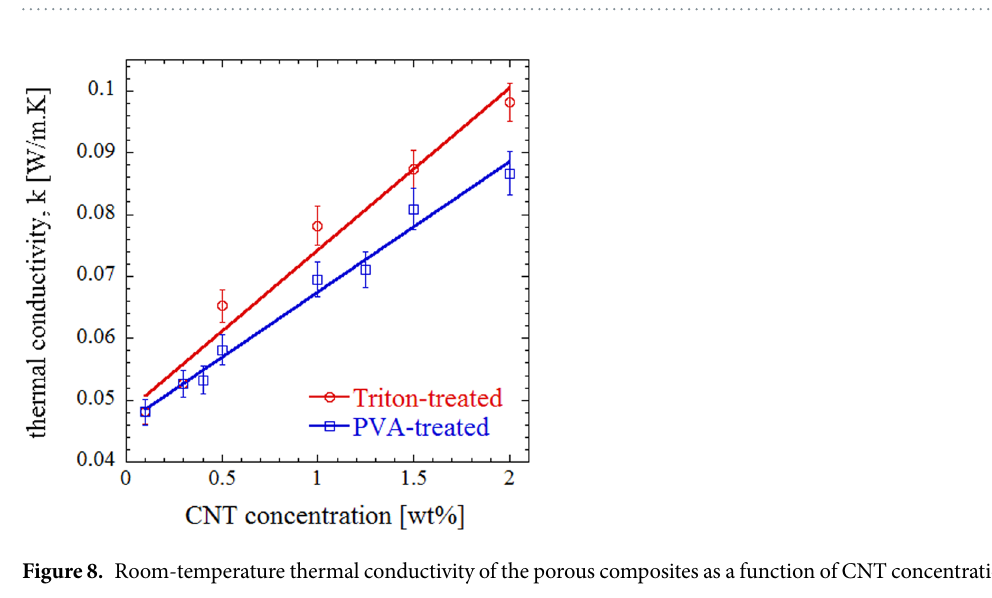
Figure 7. The electrical conductivity of the porous composites as a function of CNT concentration.